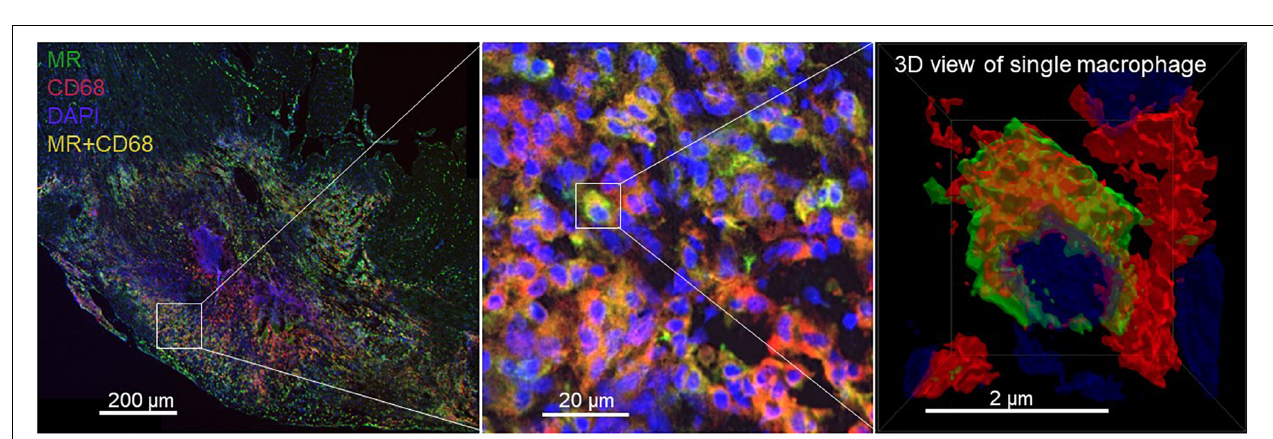
FIGURE 6 | Binding specificity test in mice. (A) Ex vivo evaluation of 68 Ga-NOTA-anti-MMR Nb biodistribution in infarcted (7 days after coronary ligation) and non-infarcted (sham-operated) wildtype and MR-knockout mice hearts and corresponding H.E. staining. (B) Autoradiography image-derived infarct-to-remote area uptake ratio (derived from n = 4 MI wildtype and n = 4 MR-knockout mice injected with 68 Ga-NOTA-anti-MMR Nb). QL = quantum level.